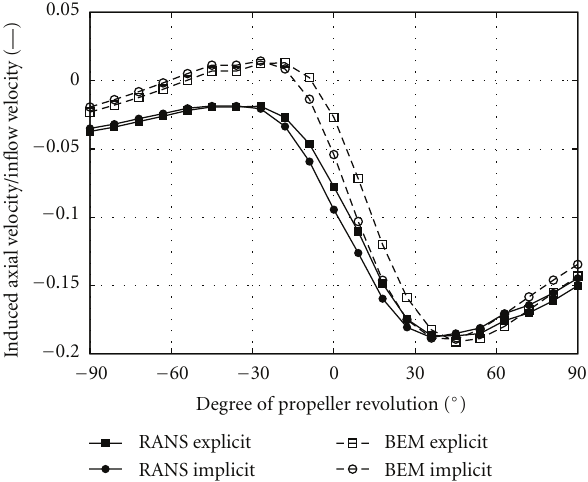
Figure 5: Normalised induced velocities in cylindrical coordinates for a single-blade propeller (explicit coupling: r/R = 0 . 7, J = 0 . 5, dt · n = 3 . 78 ◦ , and dx = 0 . 5 R ).